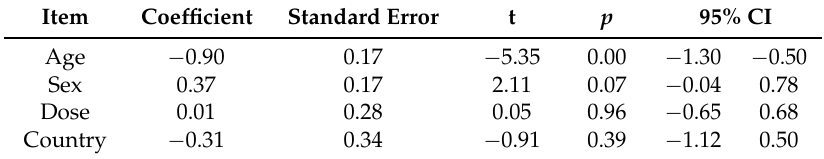
Table 2. Results of the meta-regression analysis for the percentage of monomethyl arsenic